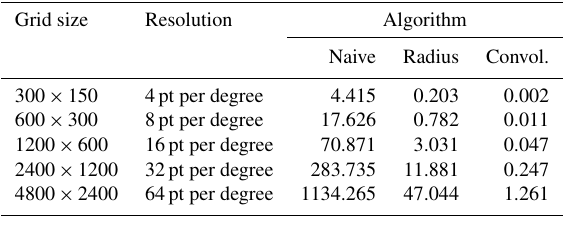
Table 1. Execution times (in s) of the investigated algorithms for varying numbers of sample points. The grid size of 2400 × 1200 points with a resolution of 32 points per degree and the Gaussian width σ = 1 . 0 ◦ are kept constant. The convolution algorithm ap- plied a 4-fold convolution.